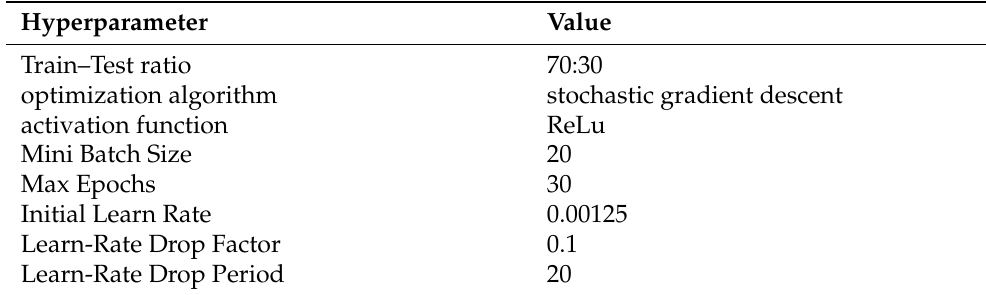
Table 6. Optimal hyperparameters used for pre-trained models.